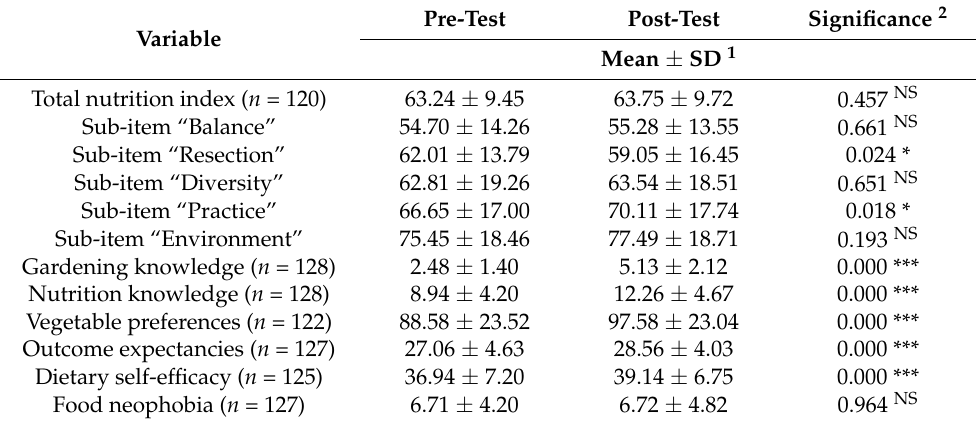
Table 5. Comparison of mediating factors related to eating behavior in children before and after the 12-session horticultural activity program ( N = 136).